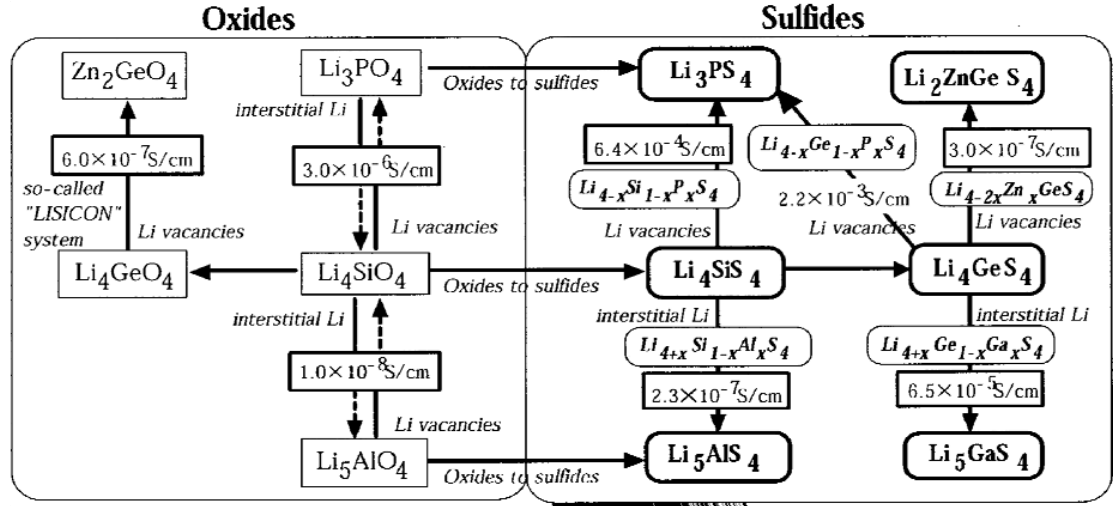
Figure 6. The concept of material design for the lithium superionic conductor (LISICON) system, and materials belonging to the LISICON (oxides) and the thio-LISICON (sulfides) are summarized